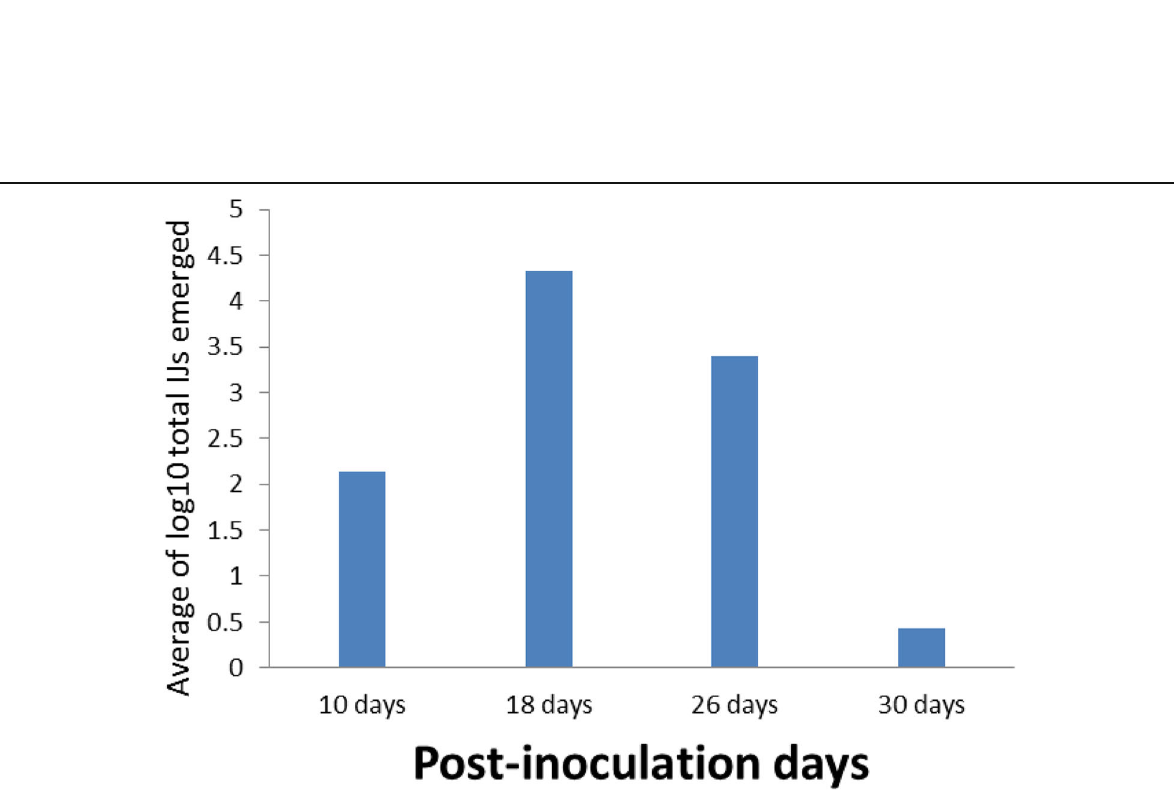
Fig. 2 Average numbers of emerging infective juveniles (IJs)/ Temnorhynchus baal larva for 15 Heterorhabditis indica populations in sandy soil. Numbers among all post-inoculation days are significantly ( P ≤ 0.05) different according to